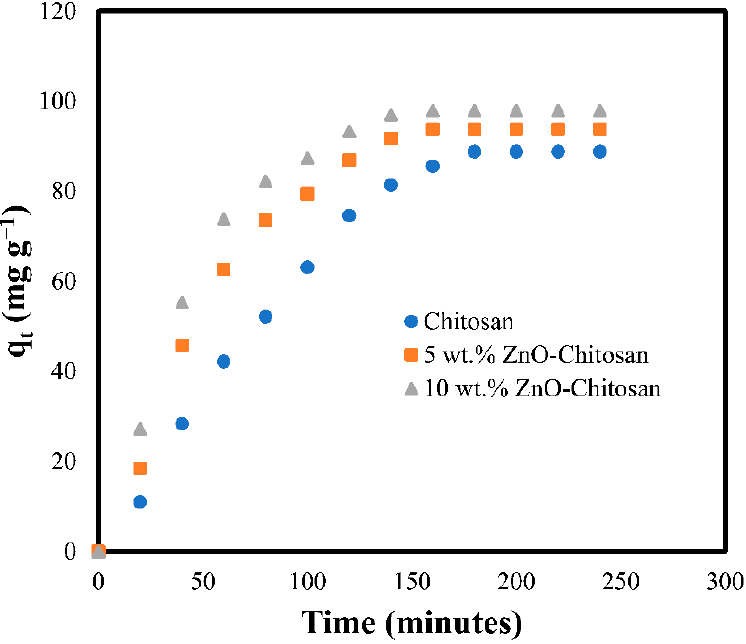
Figure 4. Effect of contact time for the dye adsorption onto chitosan and the